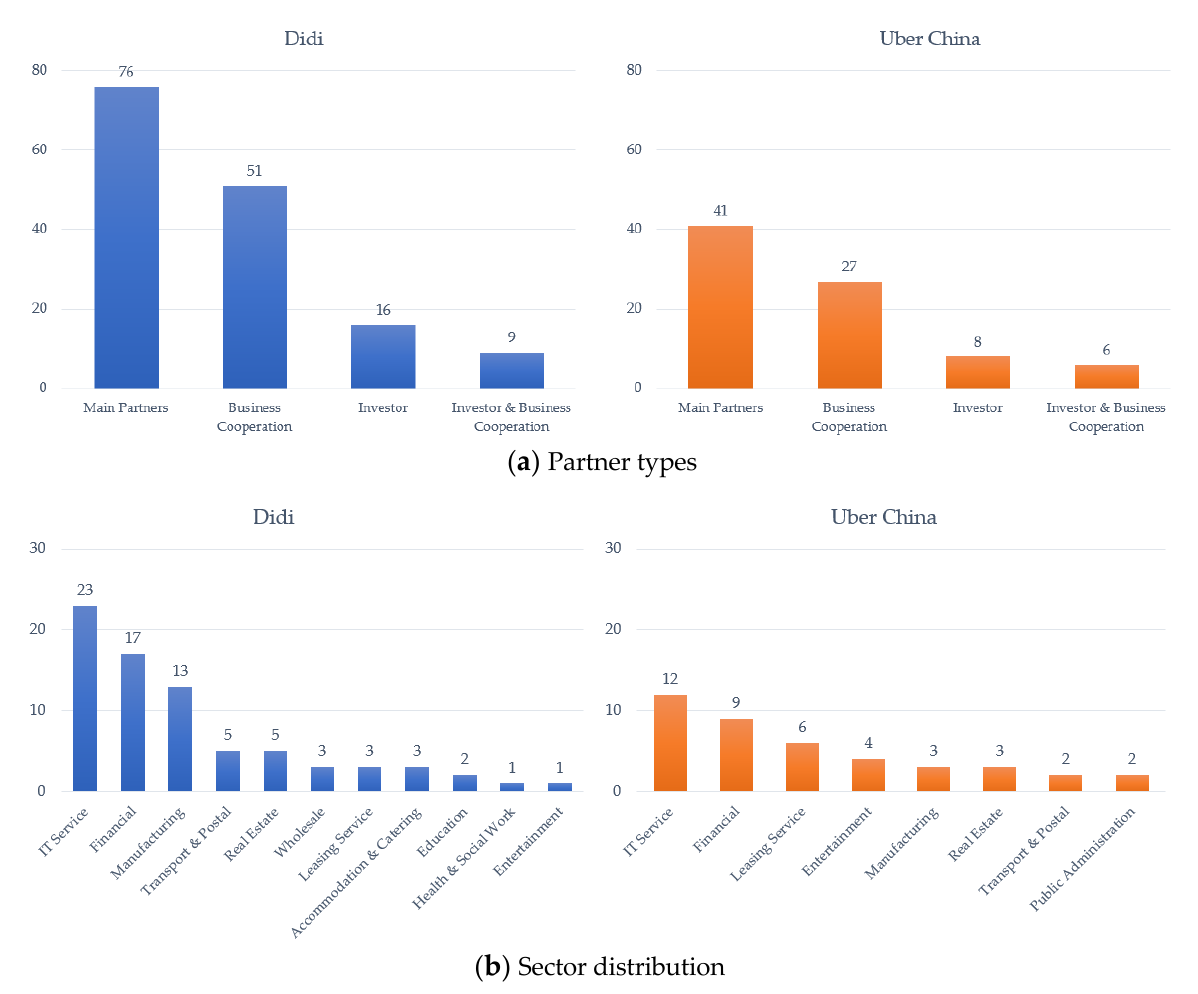
Figure 8. Partnership information of DiDi and Uber China.